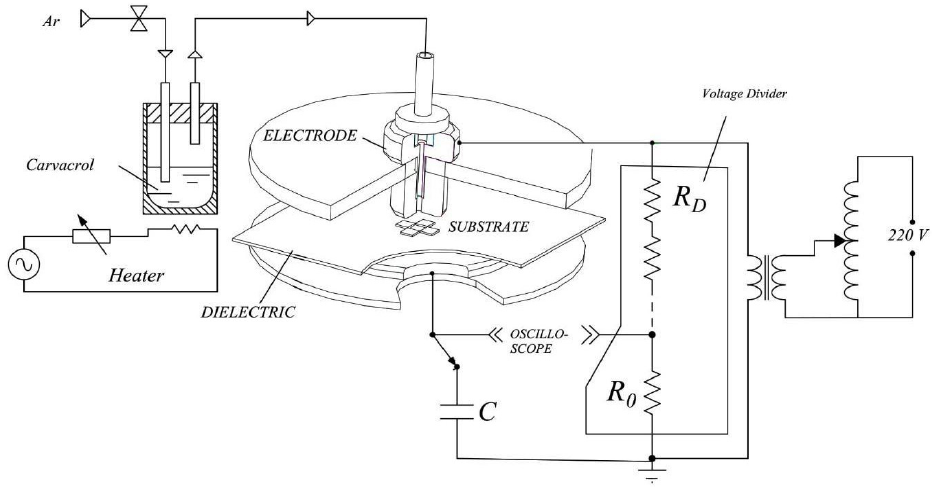
Figure 1. Schematic representation of the experimental setup.